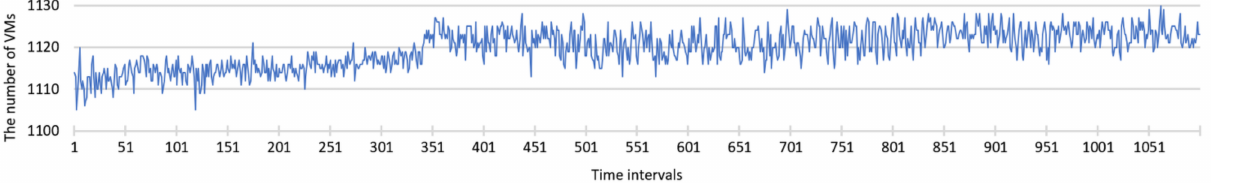
(RAM) of each VM. The requested memory can range from 1 to 512 GB per VM, but over